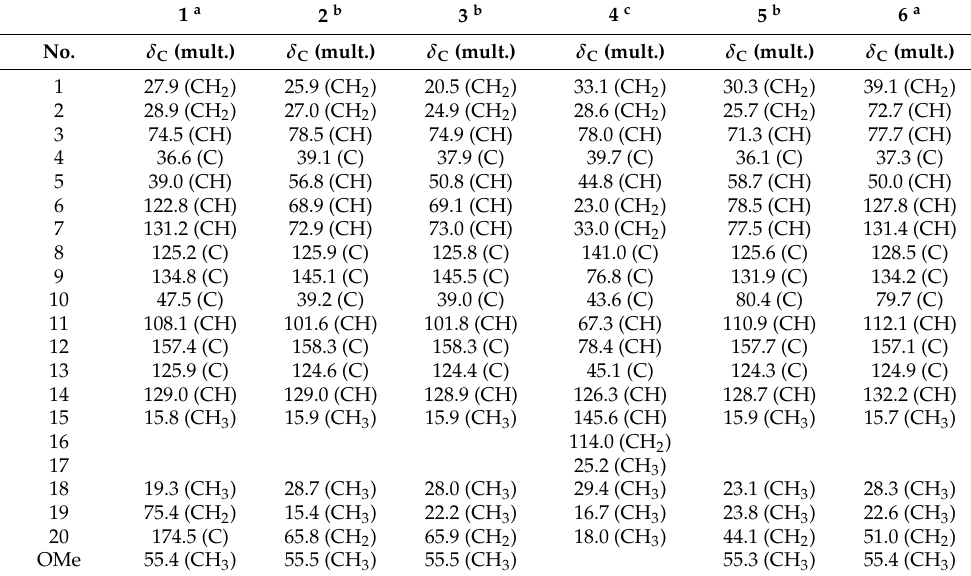
Table 2. 13 C NMR spectroscopic data of compounds 1 – 6